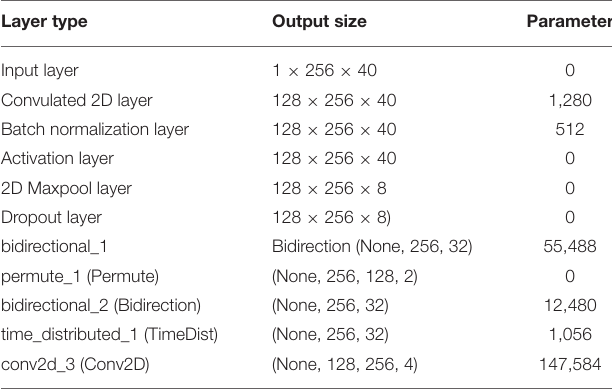
TABLE 3 | Parameters—VGG16.